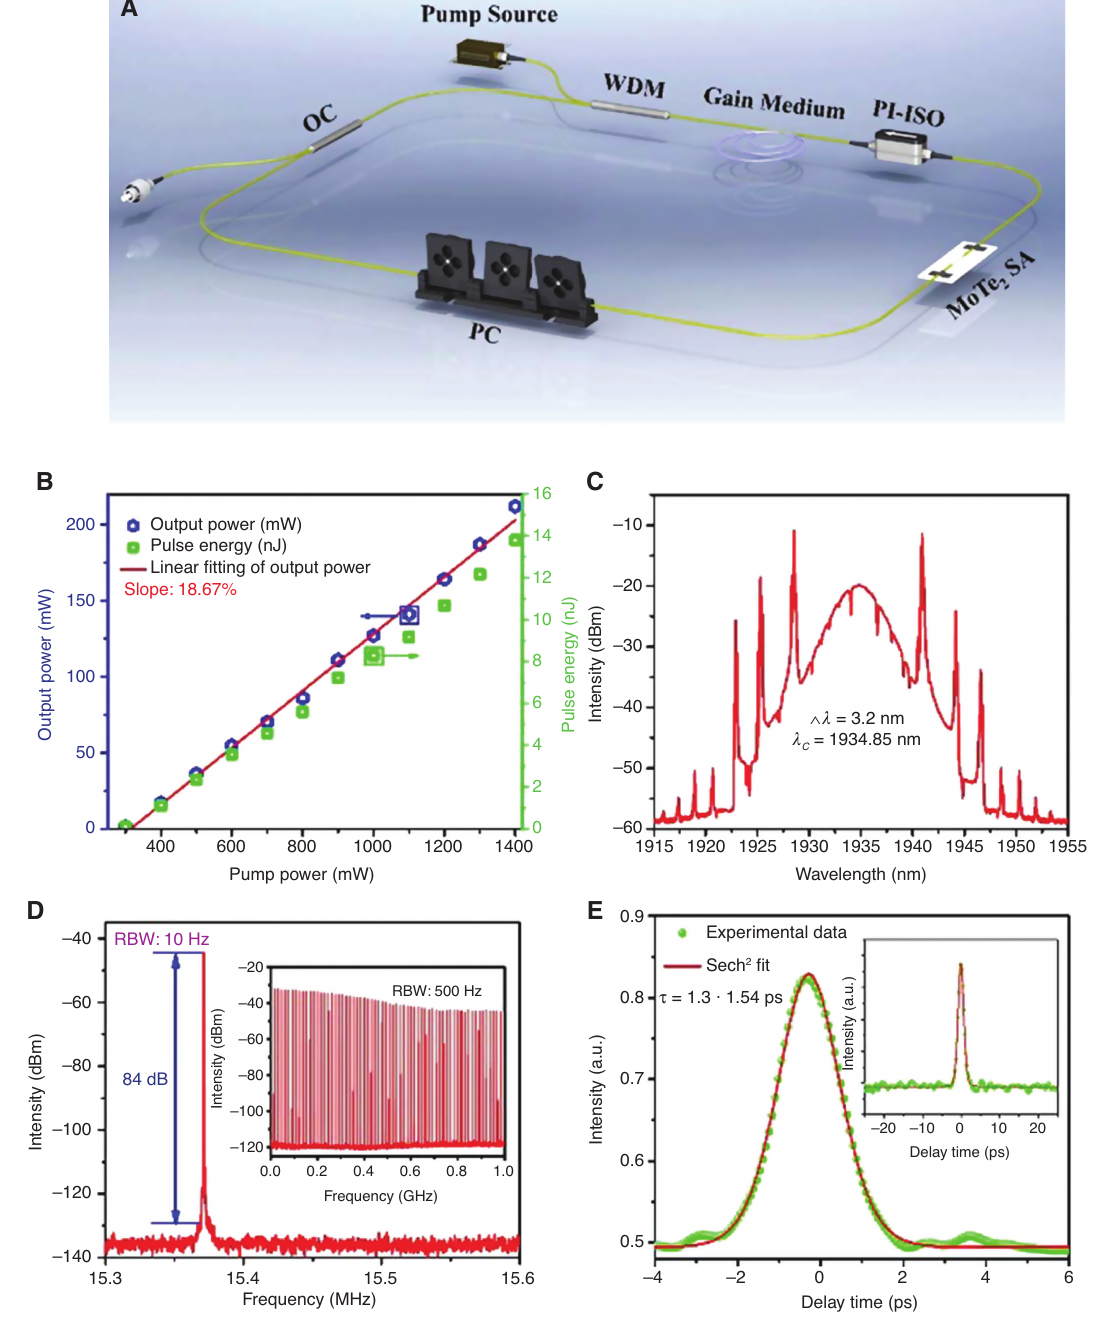
-decorated microfiber SA. Figure 7: Er- or Tm-doped fiber laser with a MoTe 2 (A) Experimental setup. (B) Relationship between the pump power and the laser output power. (C) Optical spectrum with the bandwidth of 3.2 nm. (D) Radio frequency spectrum at a fundamental frequency of 15.37 MHz (inset: the wideband RF spectrum). (E) Autocorrelation trace for the output pulse (inset: autocorrelation trace with a large range of 50 ps). Reproduced with permission [198]. Copyright 2018, The Optical